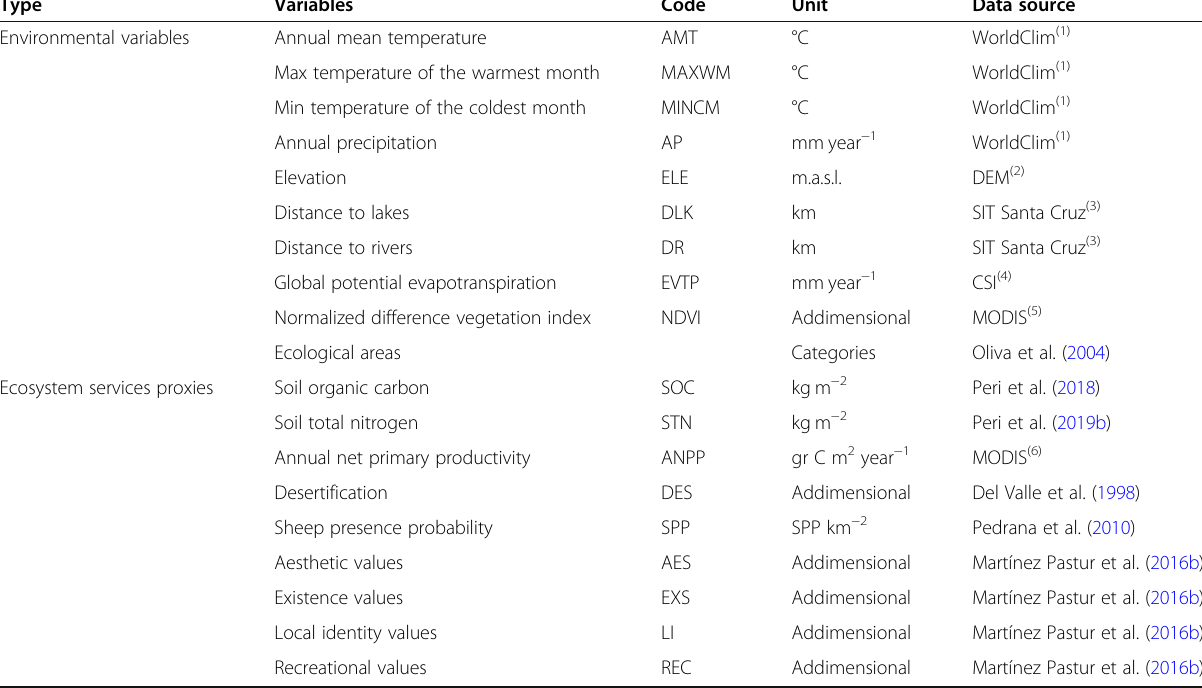
Table 3 Variables used to analyse the map of potential biodiversity of vascular plant species in Santa Cruz